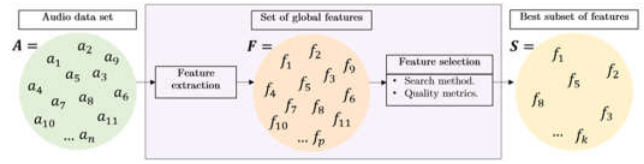
Figure 1. General process of our approach.